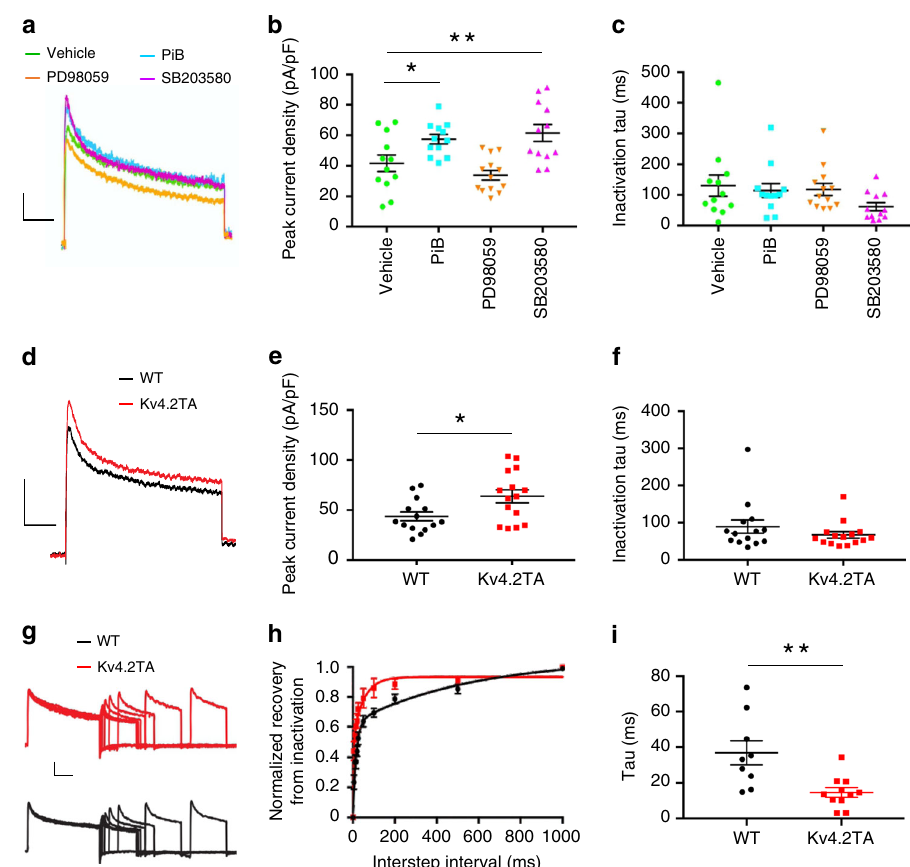
Fig. 6 P38-Pin1-Kv4.2 pathway regulates A-current. a – c I A recorded from outside-out somatic patches from CA1 pyramidal cells from WT mice. a , Trace of transient I A. inactivating I A was isolated by subtracting total K + measured from a step to + 40 mV from a − 120 mV pre-pulse from a subsequent step to + 40 mv from − 30 mV. Scale: 10 pA/100ms. b I fi cantly increased with PiB ( n = 12) or SB203580 ( n = 12) but not A density in outside-out patches is signi PD98059 ( n = 13), ordinary one-way ANOVA (two-tailed), * p < 0.05, ** p < 0.01. c No signi fi cant difference in decay kinetics was observed among the drug treatments and vehicle control, Kruskal – Wallis test (two-tailed), p > 0.05 . d Trace of transient I A in WT and Kv4.2TA mice. e I A density in outside-out patches is signi fi cantly increased in Kv4.2TA mice ( n = 15) relative to WT ( n = 14), two-tailed unpaired T -test, * p < 0.05. f No signi fi cant difference in decay kinetics was observed between Kv4.2TA and WT, two-tailed Mann – Whitney test, p > 0.05. g – i I A recovery from inactivation. g Sample traces of I A recovery from inactivation in Kv4.2TA and WT. Scale: 20 pA/200ms. h Normalized recovery curves from Kv4.2TA ( n = 11) shows faster recovery relative to WT ( n = 9). i Single-exponentials fi tted to normalized recovery curves yielded signi fi cantly reduced tau in Kv4.2TA relative to WT, unpaired two-tailed T -test. ** p < 0.01. Data are presented as mean ±